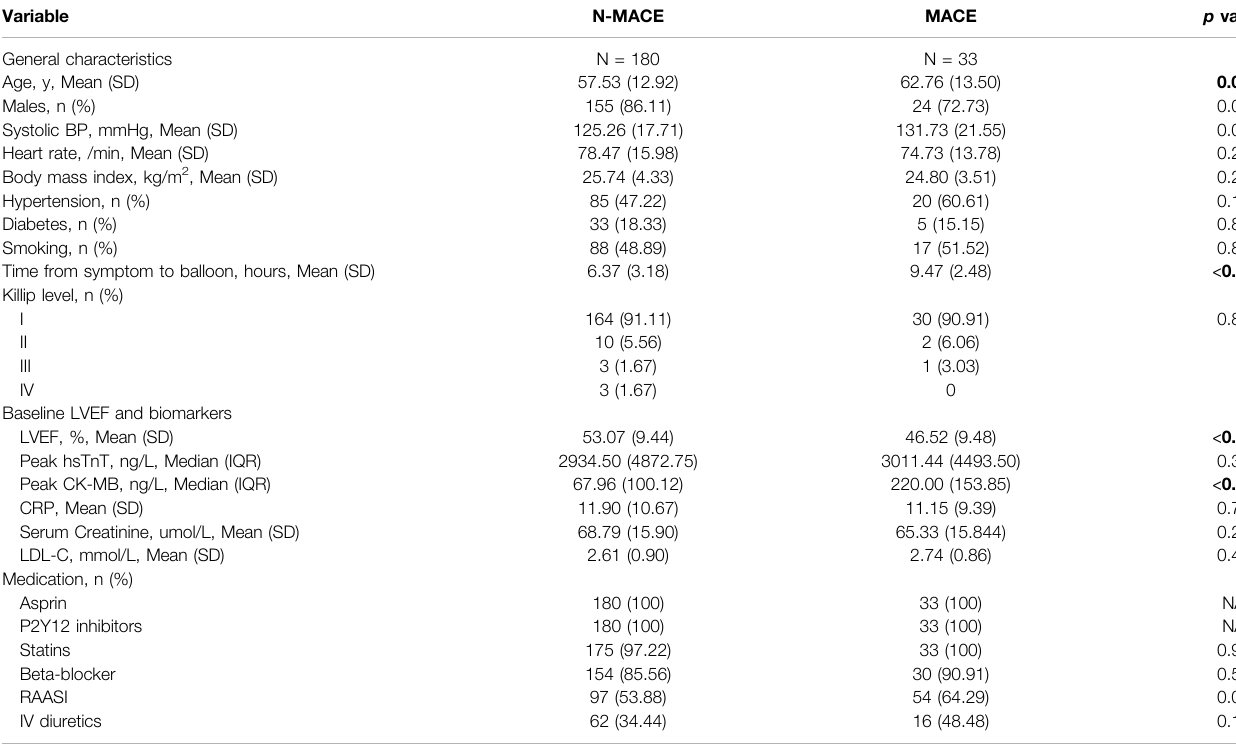
TABLE 3 | Baseline characteristics of the study population grouped by MACEs. Variable N-MACE General